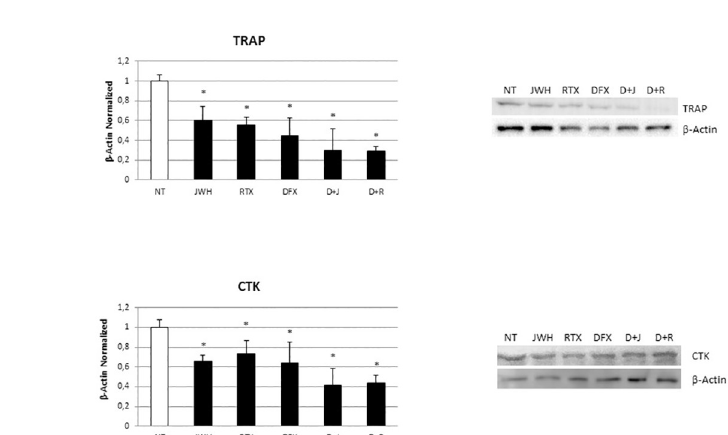
Fig 6. Effects of treatments on osteoclast biomarkers expression. Protein expression of TRAP (A) and Cathepsin K (CTK) (B) in OCs, differentiated or not in presence of DFX [5 μ M], from 5 Childhood cancer survivors (CCS) after 48h of exposure with JWH-133 [100nM] and RTX [5 μ M], determined by Western Blot starting from 15 μ g of total lysate. The most representative images are showed. The Image Studio Digits software has been used for the protein bands density detection. The intensity ratios of immunoblots compared to CTR, considered as 1, were quantified after normalization with the housekeeping protein β -Actin. Histogram shows the relative quantification for TRAP and CTK as mean ± SD of independent experiments on each individual sample. For statistical analysis it has been used ANOVA test followed by a post hoc test. � Indicates p � 0.05 compared to the untreated control (NT).